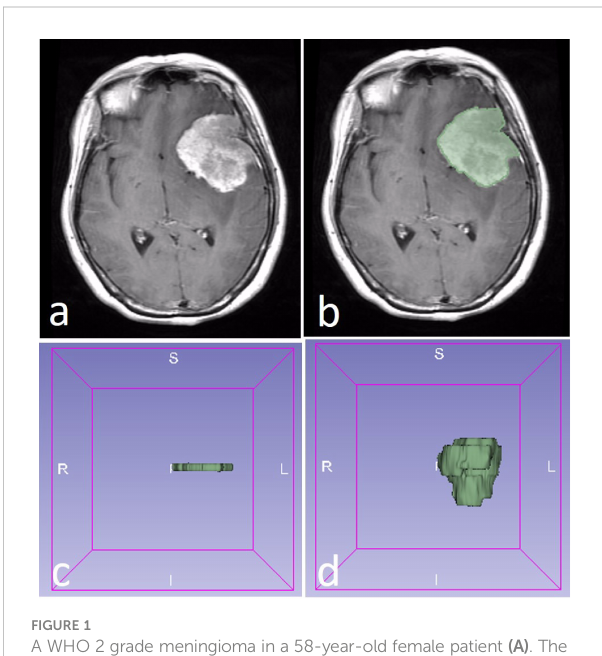
FIGURE 1 A WHO 2 grade meningioma in a 58-year-old female patient (A) . The region of interest (ROI) was drawn along with the edge of the tumor (B) . The 2D ROI (C) and 3D ROI (D) were performed in the tumor.